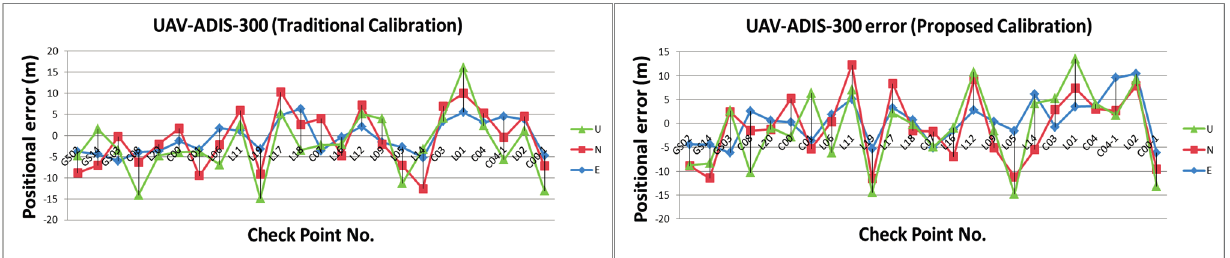
Figure 27. DG error based on ADIS 16488 with 300